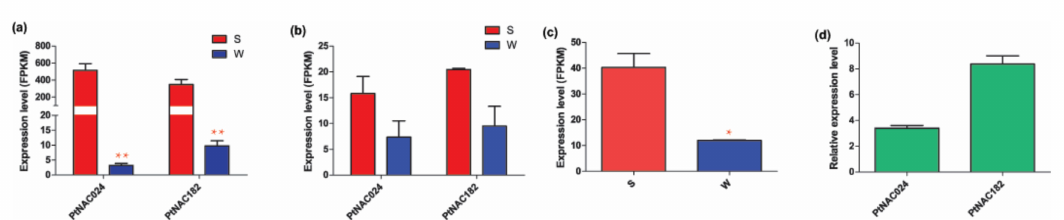
Figure 8. Expression analysis of di ff erentially expressed NACs in response to salt stress based on RT-qPCR of 84K poplar and RNA-Seq of Populus and Arabidopsis . ( a ) Expression of PtNAC024 and PtNAC182 of 84K poplar based on RNA-Seq. ( b ) Expression of PtNAC024 and PtNAC182 of P. simonii × P. nigra based on RNA-Seq. ( c ) Expression of the gene homolog of PtNAC024 and PtNAC182 in Arabidopsis ( AT4G27410.2 ) based on RNA-Seq. ( d ) Relative expression of PtNAC024 and PtNAC182 of 84K poplar based on RT-qPCR. The expression level based on RNA-Seq was measured as FPKM and the relative expression was calculated using the 2 − ∆∆ Ct method, defined as: ∆∆ C t = (C t-target − C t-control ) 2 − (C t-target − C t-control ) 1 . S indicates samples treated with NaCl and W the controls treated with regular water. Stars represent t -test results of gene expression after salt treatment compared to that of the controls. * indicates a significant di ff erence at p < 0.05 and ** at p < 0.01.